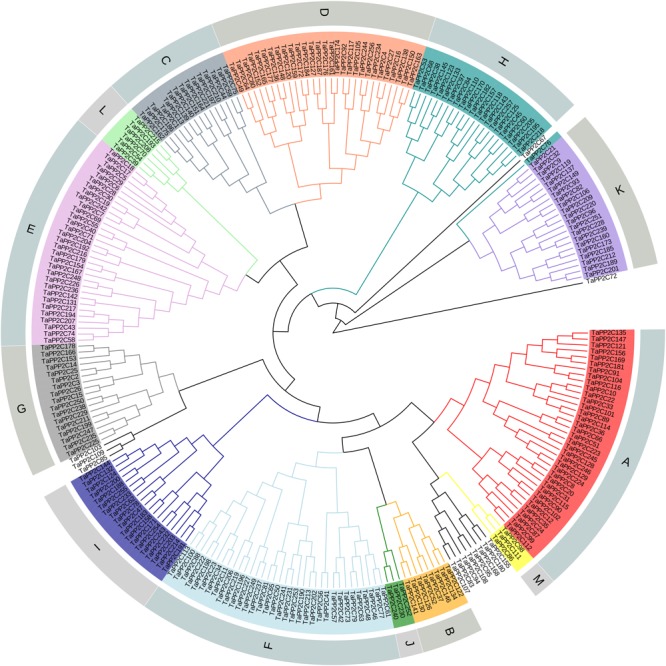
Phylogenetic analysis of TaPP2C proteins. A total of 257 TaPP2C proteins were used to construct the phylogenetic tree using neighbor-joining method with ClustalX 2.1 and MEGA 6.0 with 1,000 bootstrap replicates. The PP2C proteins are divided into 13 distinct groups (A–M), which are indicated with different colors except for the ungrouped PP2C proteins.